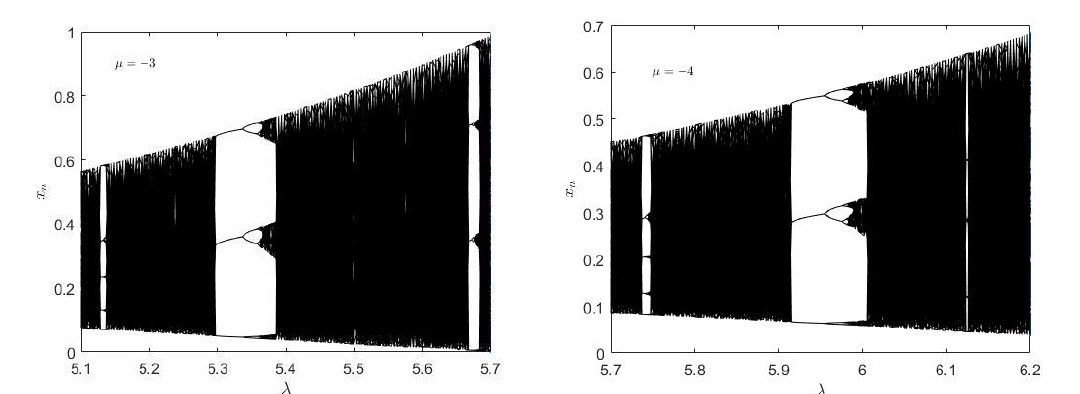
Figure 8. Period-3 window for μ = − 3 Figure 9. Period-3 window for μ = −